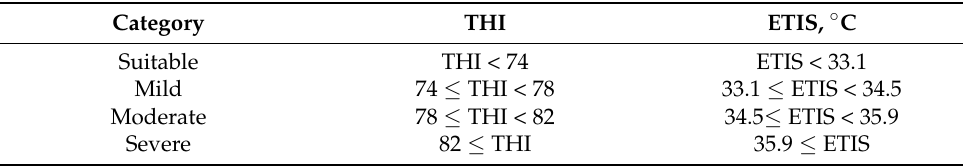
Table 2. ETIS heat stress threshold. Threshold distribution of ETIS was determined according to the threshold distribution of THI and the correlation equation between THI and ETIS.